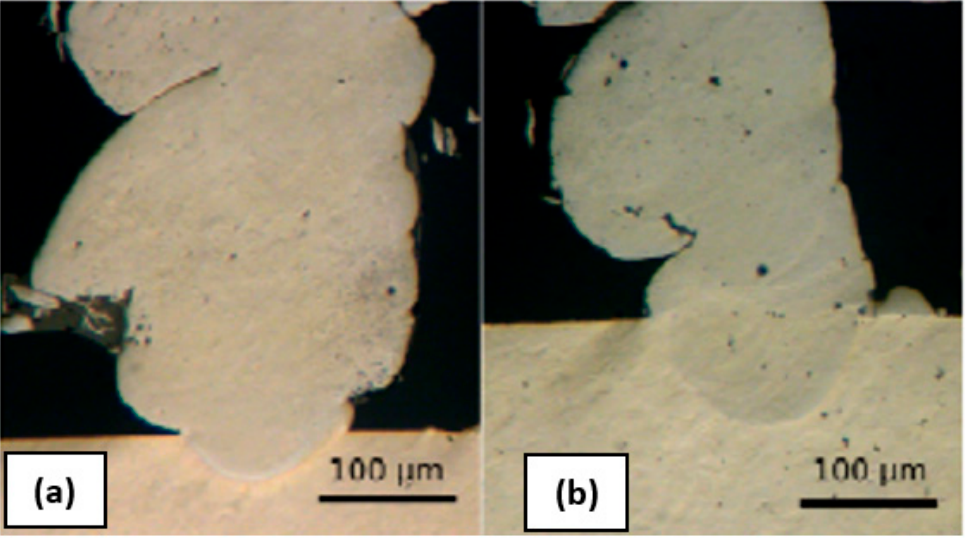
Figure 14. Iron rings fabricated by ( a ) an 80 MHz fs laser; ( b ) a CW laser (Adapted from reference [7]). The penetration depth of the fs-laser-fabricated iron-powder sintered sample was ap- proximately 30 µm, while the penetration depth of the CW fabricated sample was 75 µm. This difference was attributed to the smaller HAZ in the case of fs laser-based 3D printing.